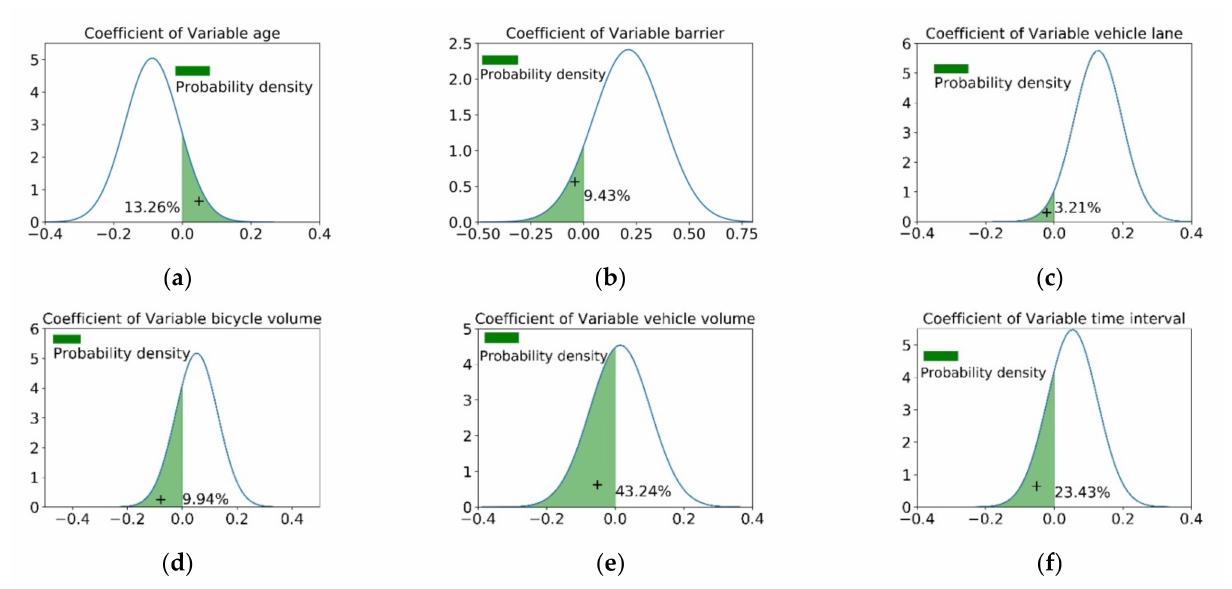
Figure 4. Distribution of parameters estimation for variables. ( a ) Distribution of parameters esti- mation for age; ( b ) Distribution of parameters estimation for barrier; ( c ) Distribution of parameters estimation for vehicle lane; ( d ) Distribution of parameters estimation for bicycle volume; ( e ) Distri- bution of parameters estimation for vehicle volume; ( f ) Distribution of parameters estimation for time